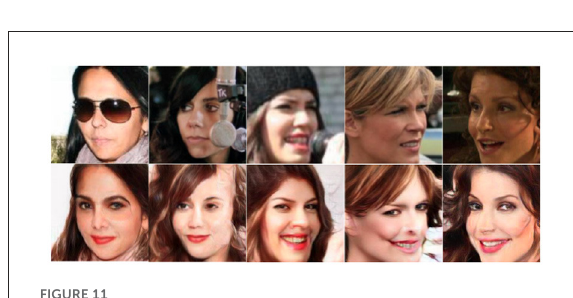
FIGURE11 Failed case with artifacts: large occlusions and pose